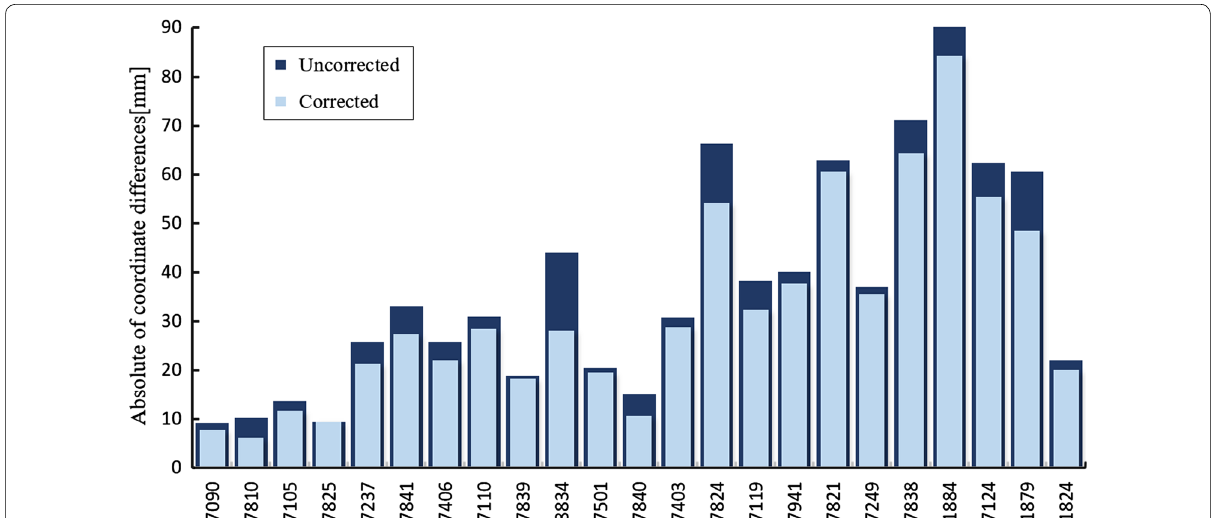
Fig. 5 Coordinate differences between the estimated SLR station coordinates and ITRF2014 before/after applying corrections of the range